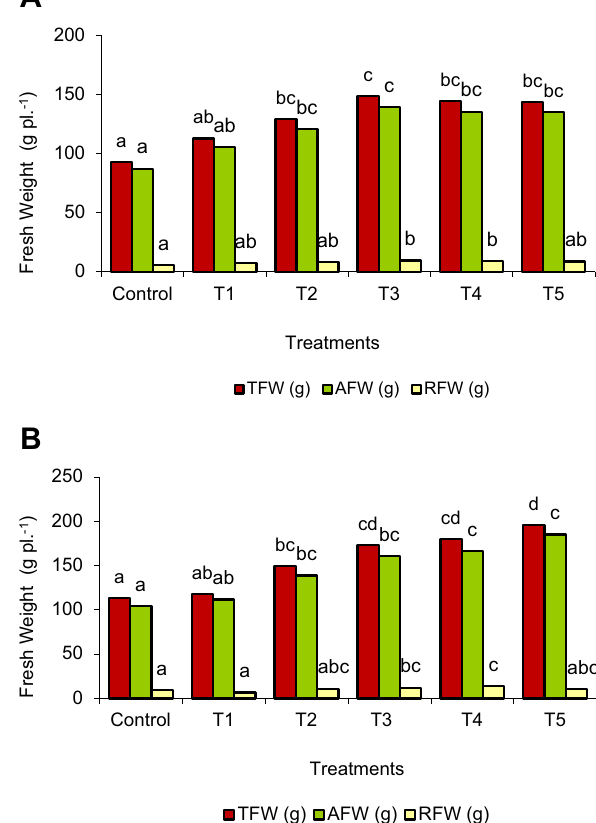
Fig. 3 Effect of different compost and mineral fertilizer dosages over the fresh weight of lettuce harvested in experimental plots. a